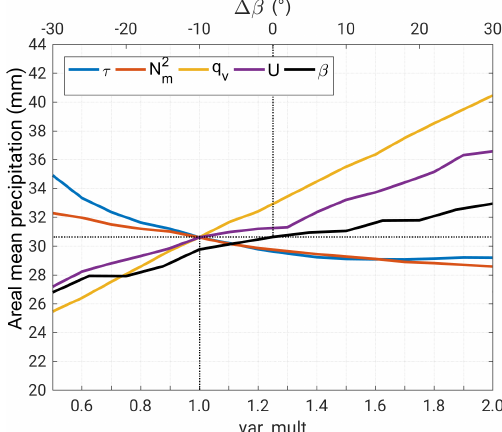
Figure 7. Areal mean precipitation (24h totals; median of the top200 event set) as a function of N 2 m , q v , U , β , and τ , perturbed by a multiplicative factor (0 . 5 ≤ var_mult ≤ 2) and changed (cid:49)β . The dotted lines indicate the values of the reference